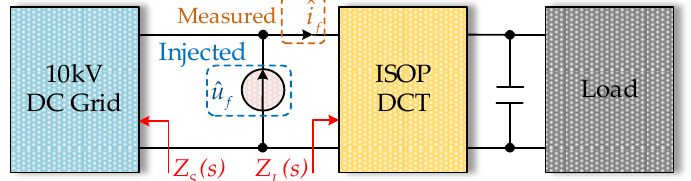
Figure 15. Impedance measurement by the disturbance injection method.